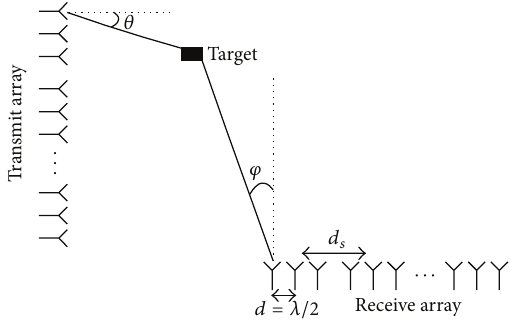
Figure 1: Bistatic MIMO radar with sparse linear